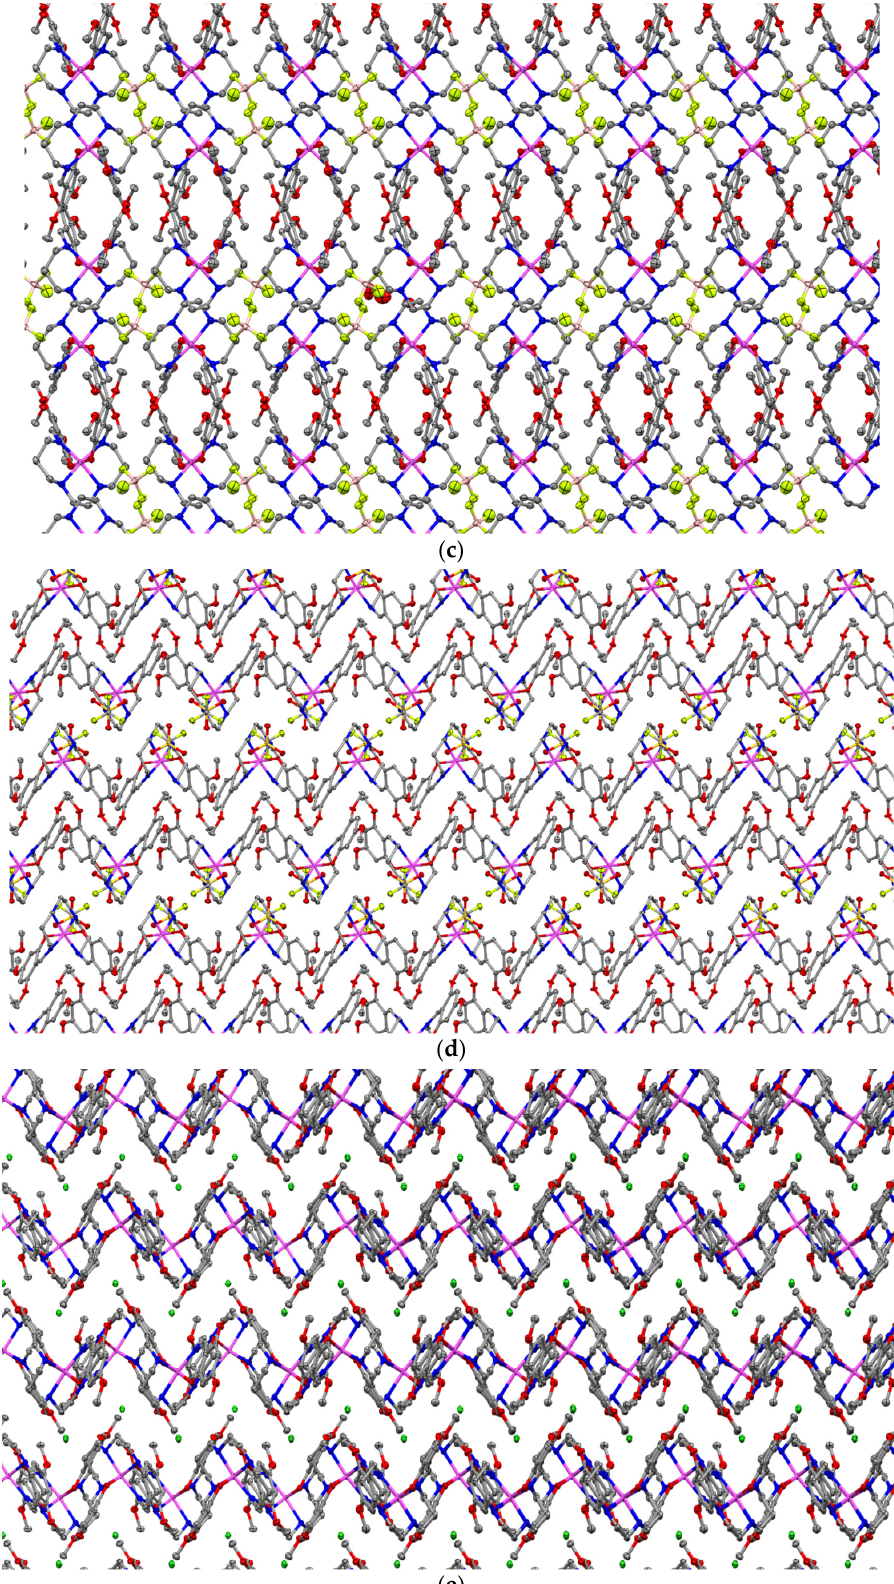
Figure 5. Long range order present in the structures of the P2 1 /n complex ( 1 ), [Mn(4,6-diOMe- sal 2 323)]ClO 4 · 0.5H 2 O ( a ), the P2 1 /c complex ( 2 ), [Mn(4,6-diOMe-sal 2 323)]NO 3 · 1.15H 2